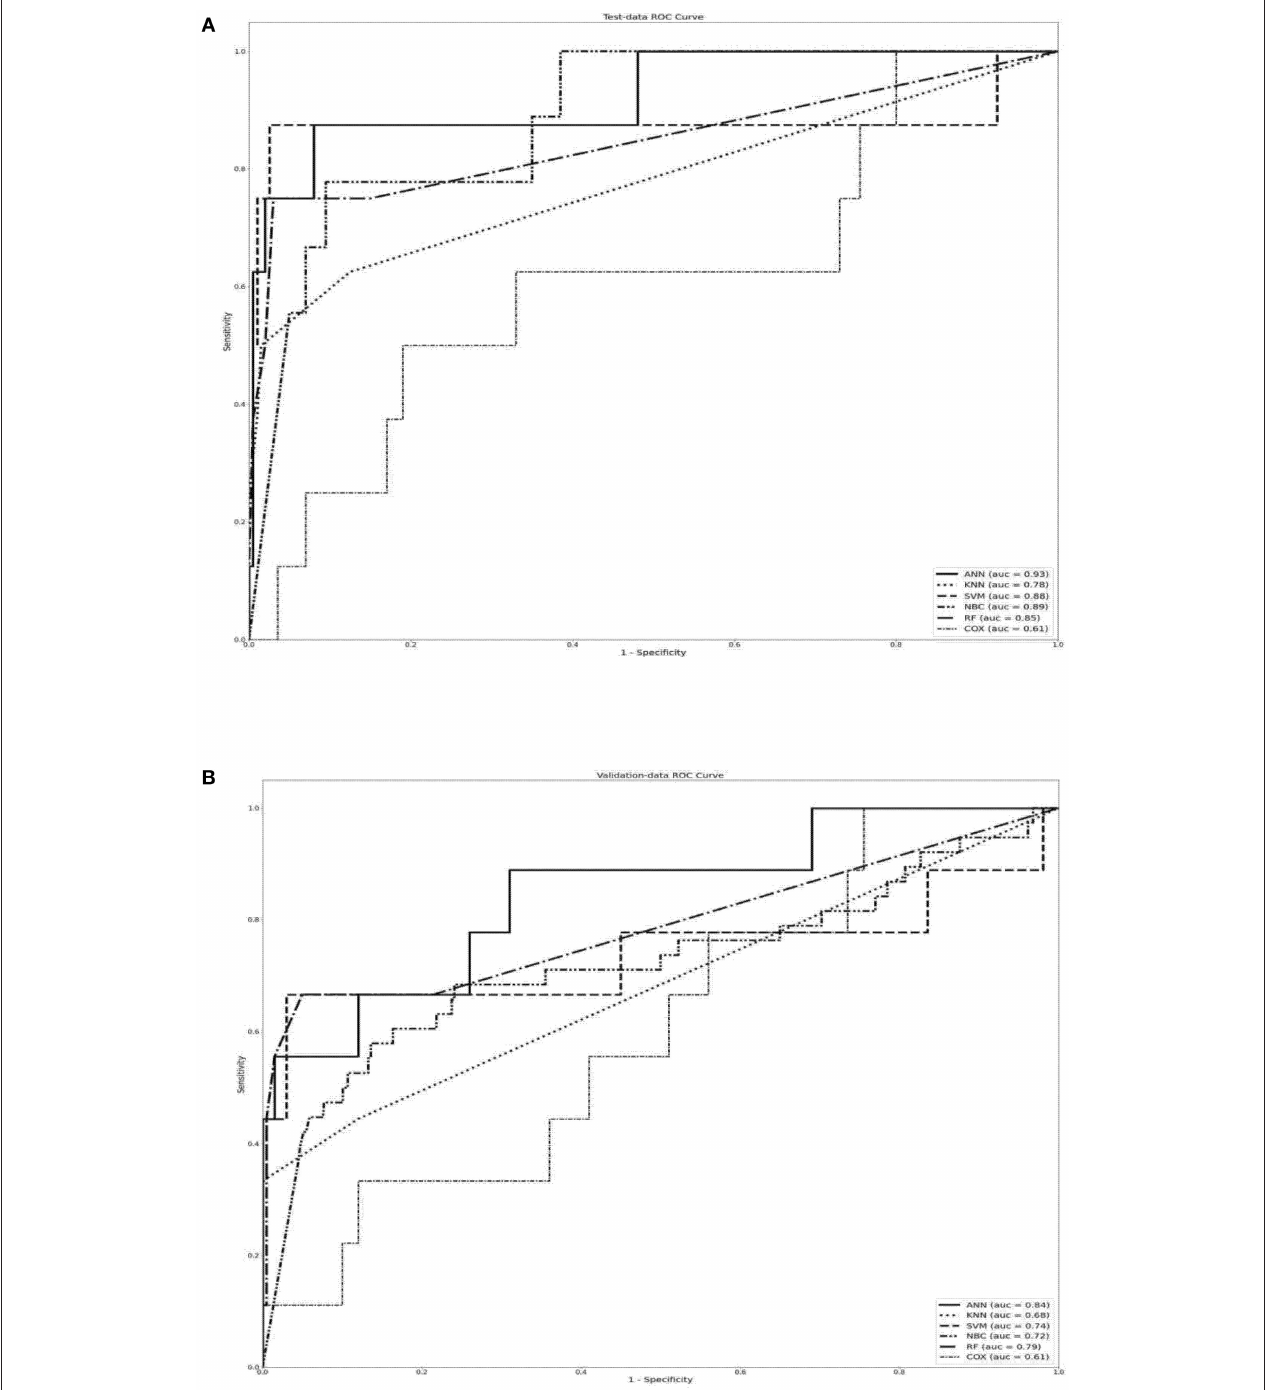
FIGURE 3 | Performance indices of forecasting models used to predict 30-day readmission in patients with stroke when using (A) training dataset, (B) testing dataset. The box plot shows the median (centers) and interquartile range (borders). In analyses of accuracy and AUROC, the ANN model had significantly higher values compared to other forecasting models ( P < 0.001). AUROC, area under the receiver operating characteristics; ANN, artificial neural network.